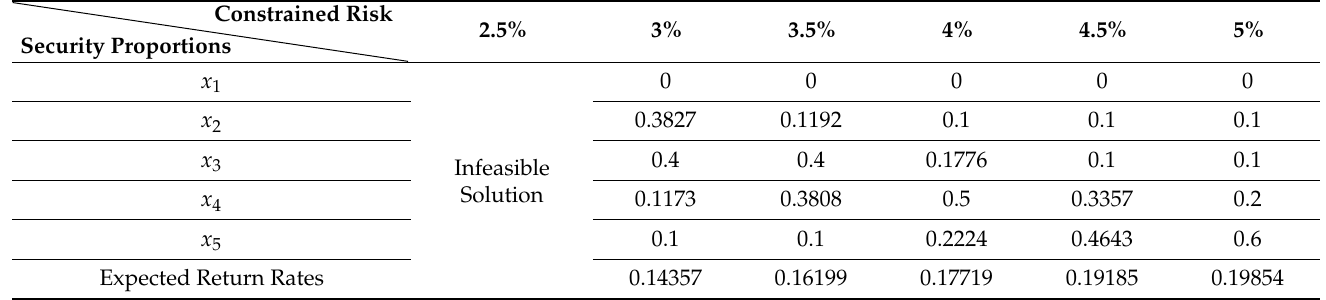
Table 4. The dimension with t = 3 and s = 2 with a guaranteed return rate (cid:101) p 1 in the proposed model.